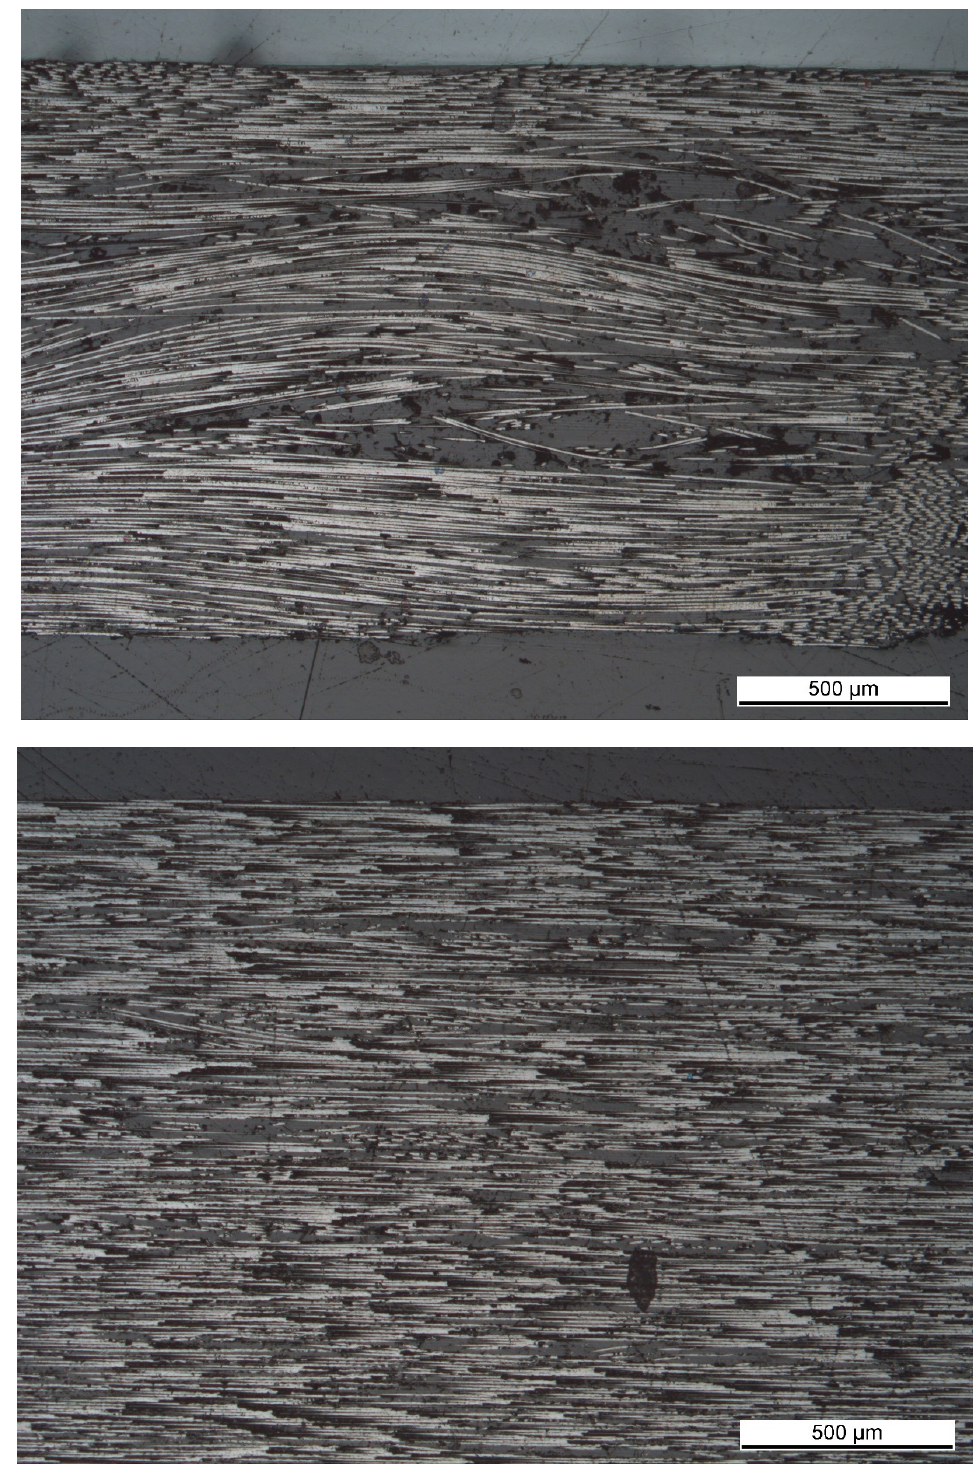
Figure A1. Local carbon fibre waviness for 3D-pinted and post-compacted straps along strap length